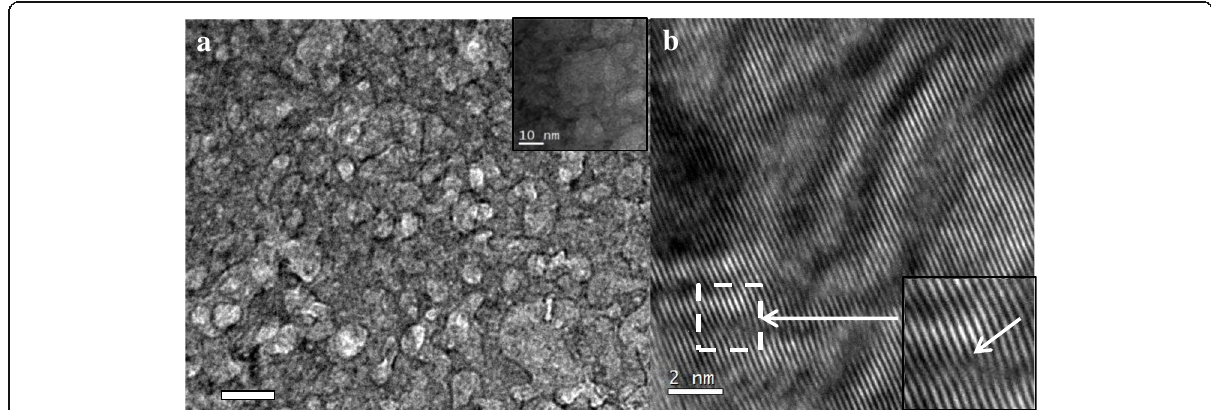
Fig. 4 Microstructures of V-4Cr-4Ti alloys after post-irradiation annealing treatment at 450 °C for 30 h. a Bubbles of bright field. b Dislocation lines of high-resolution images